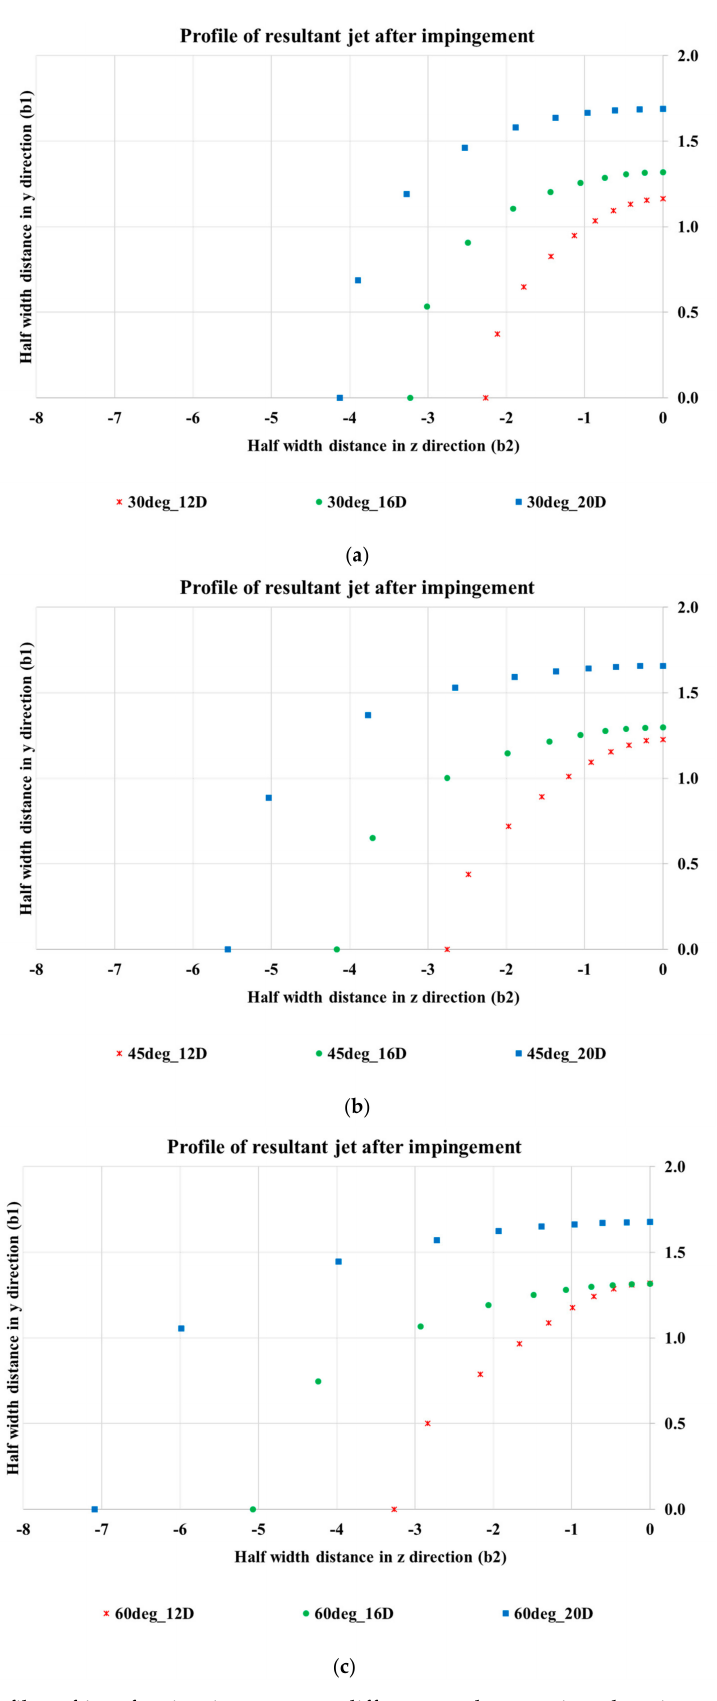
Figure 12. Profiles of jet after impingement at different angle at various locations: ( a ) 30 degree; ( b ) 45 degree; and ( c ) 60